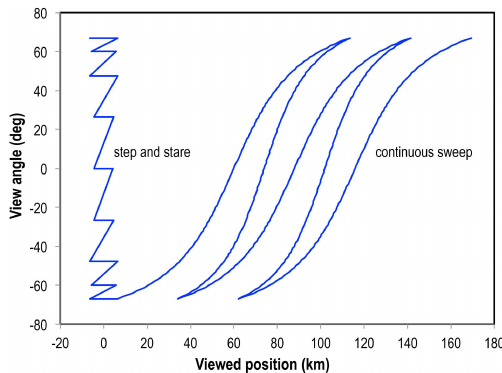
Fig. 2. Example of the AirMSPI “step and stare” mode, with nine view angles, showing view zenith angle at the center of the cam- era field of view as a function of viewed downtrack position on the ground, and the “continuous sweep” mode, in which the gimbal slews back and forth providing variable view angles and wider areal coverage than is possible in step and stare